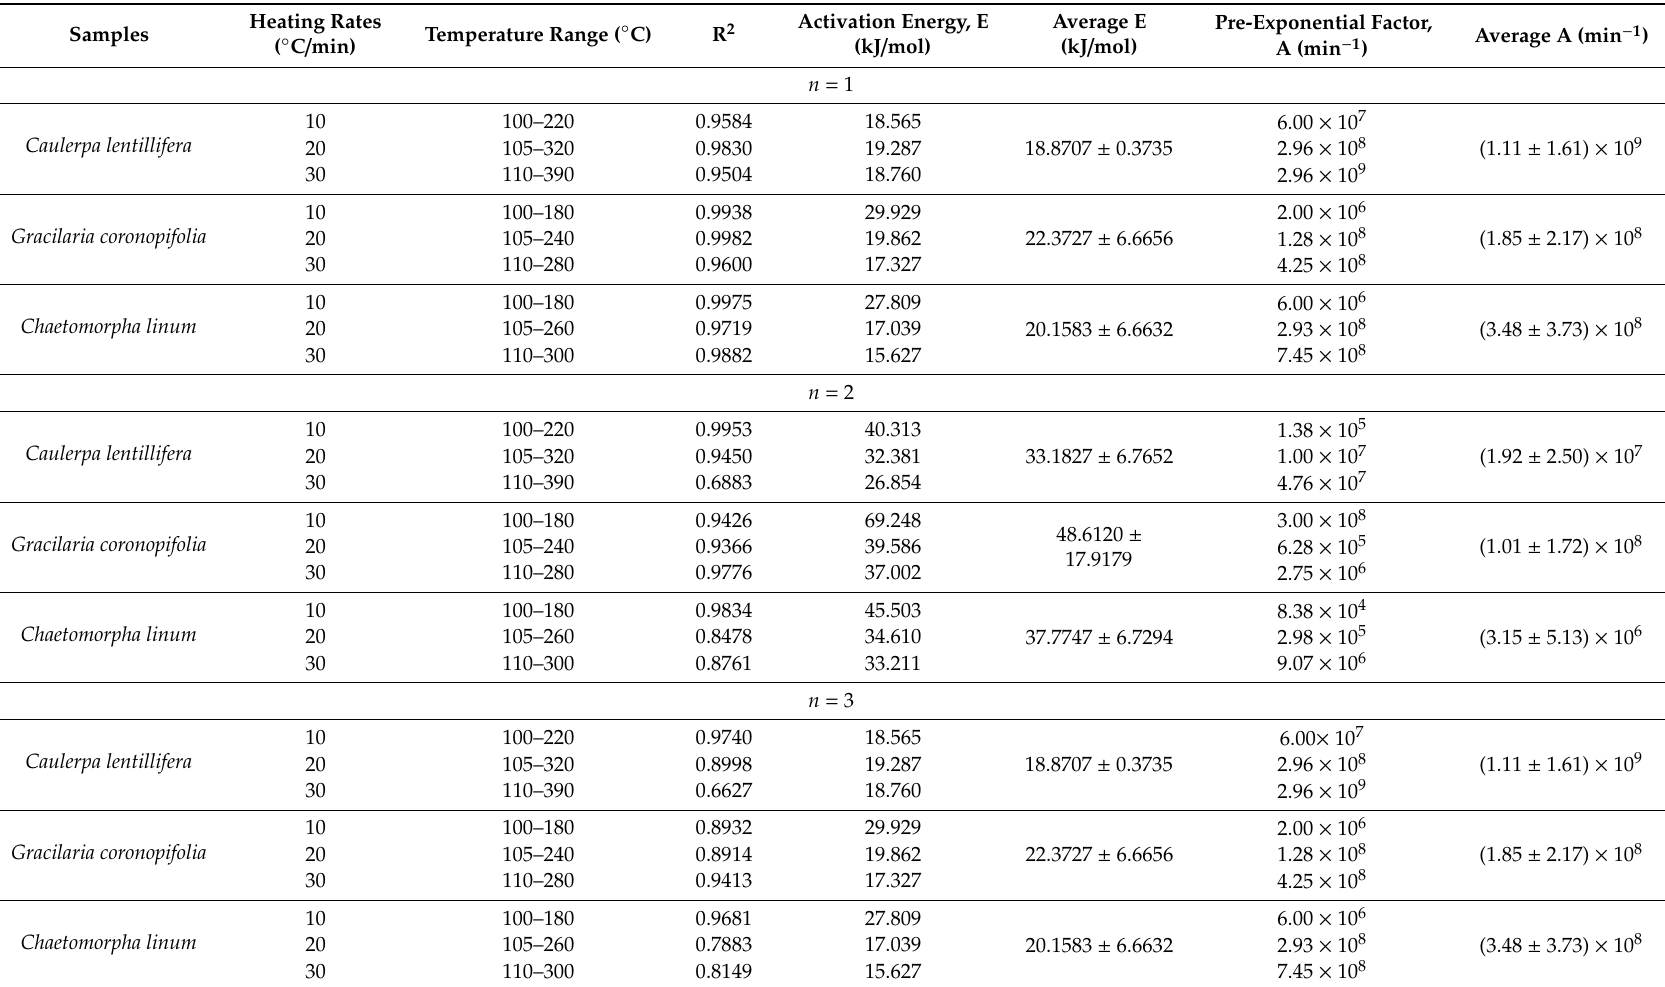
Table 2. Summary of kinetic results for three di ff erent algae biomass